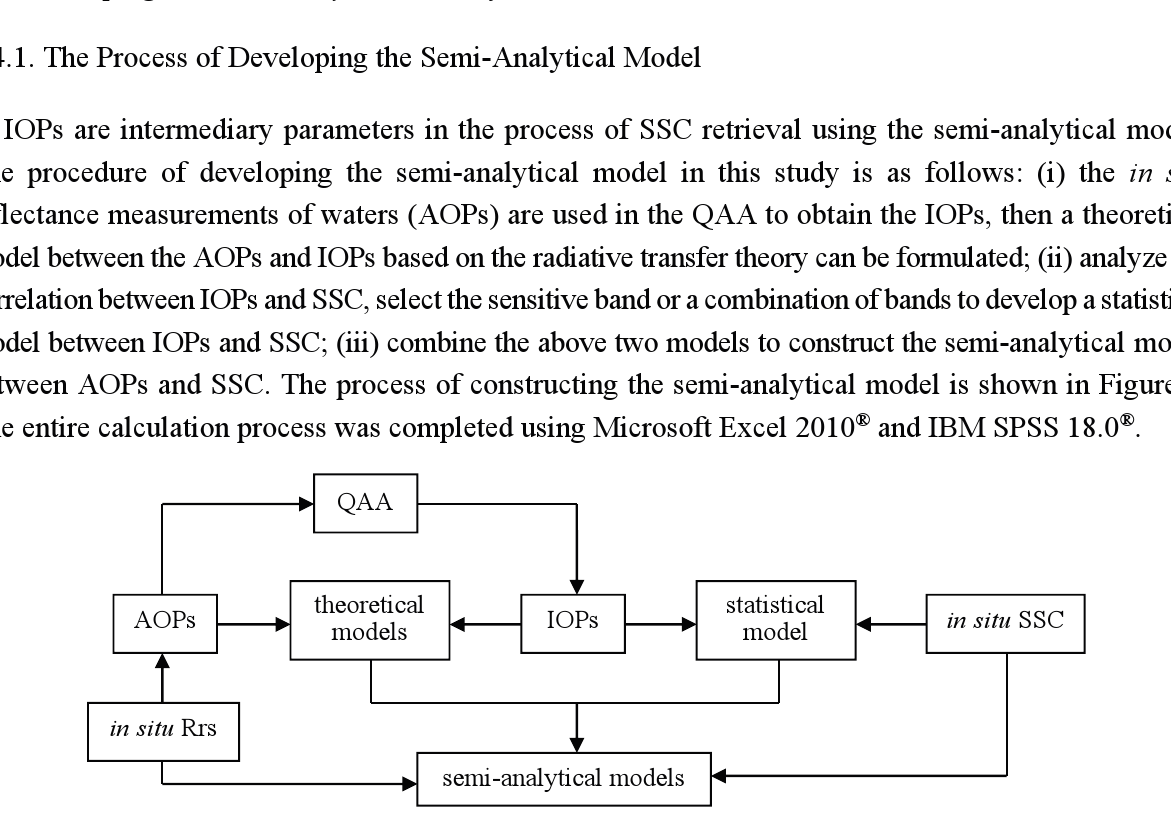
Figure 4. The flow diagram of developing the semi-analytical model. The procedure mainly includes three parts: Build a theoretical model between the apparent optical properties (AOPs) and inherent optical properties (IOPs) based on the quasi-analytical algorithm (QAA), select the sensitive band or a bands combination to develop a statistical model between IOPs and suspended sediment concentration (SSC) and combine the above two models to construct the semi-analytical model between AOPs and SSC.